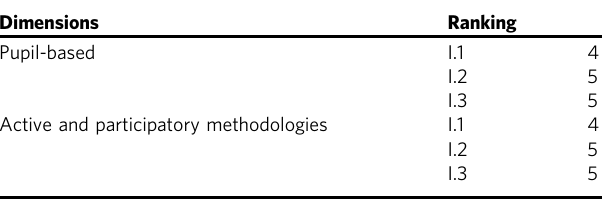
Table 9 Dimensions of the model (TB.2) and the level of development for each